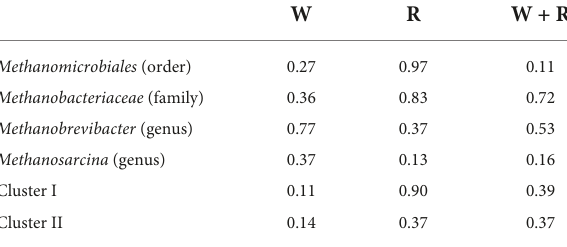
TABLE 2 Composition of the methanogenic communities in the four treatments. Treatment